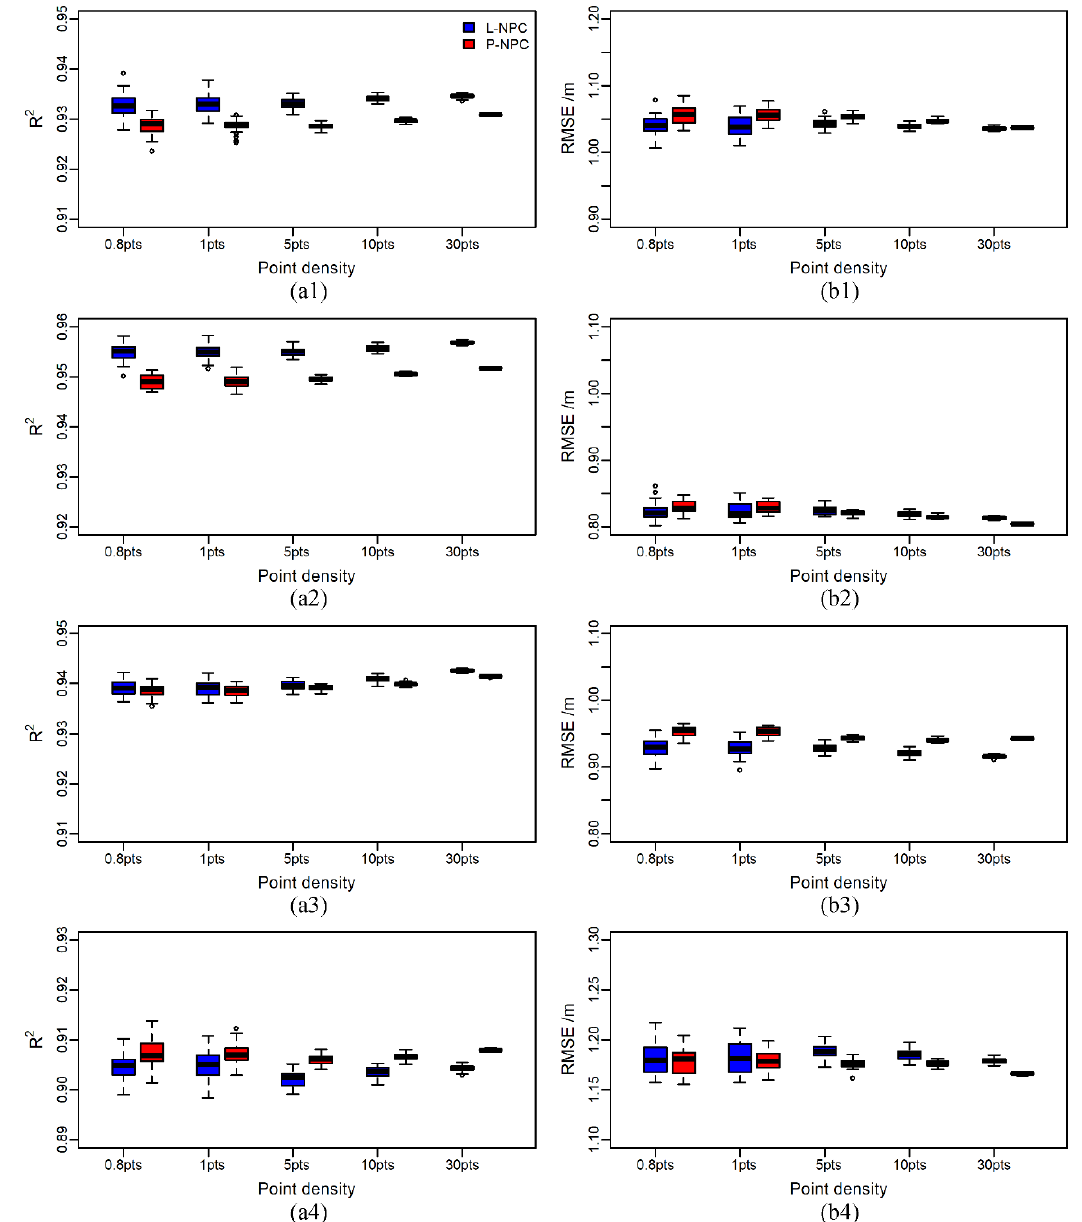
Figure 12. Boxplots of forest stand height estimates using thinned point clouds. ( a1 , b1 ) for mean height, ( a2 , b2 ) for Lorey’s height, ( a3 , b3 ) for dominated height, ( a4 , b4 ) for median height.